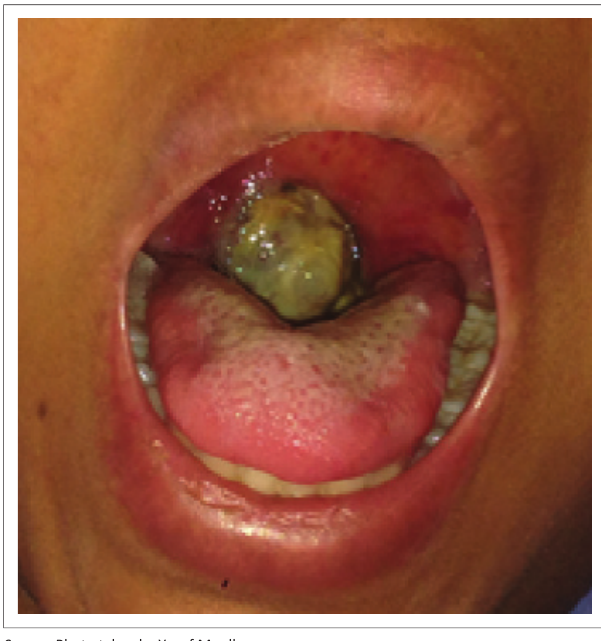
FIGURE 1: On examination, a large tonsillar lesion was